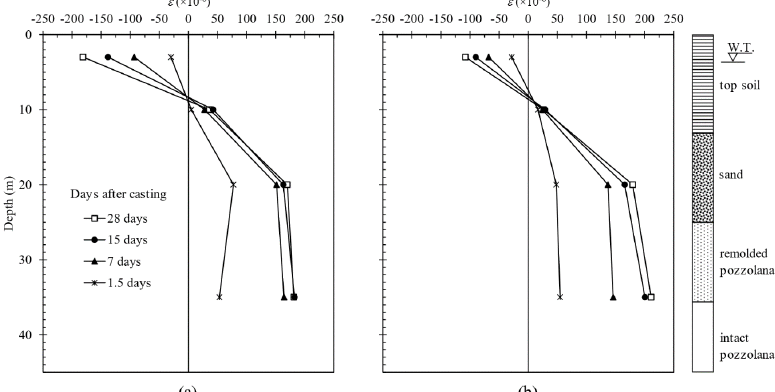
Figure 1. Strain measurements along the depth for two different drilled shafts; (a) pile A and (b) pile C [4].